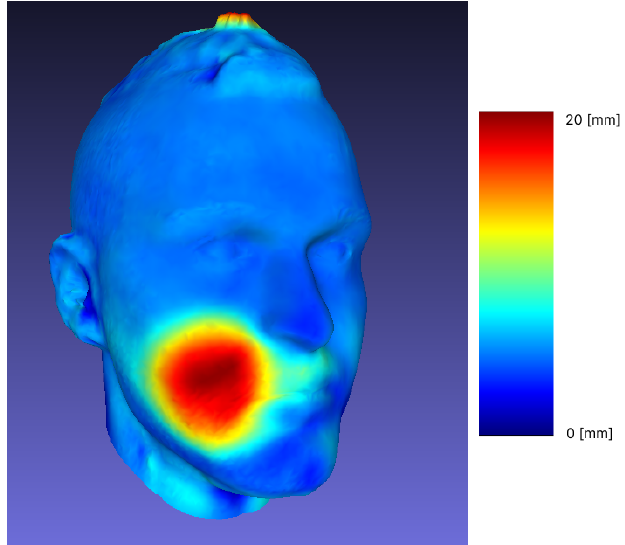
Figure 4. Visualization of differences on 3D meshes.